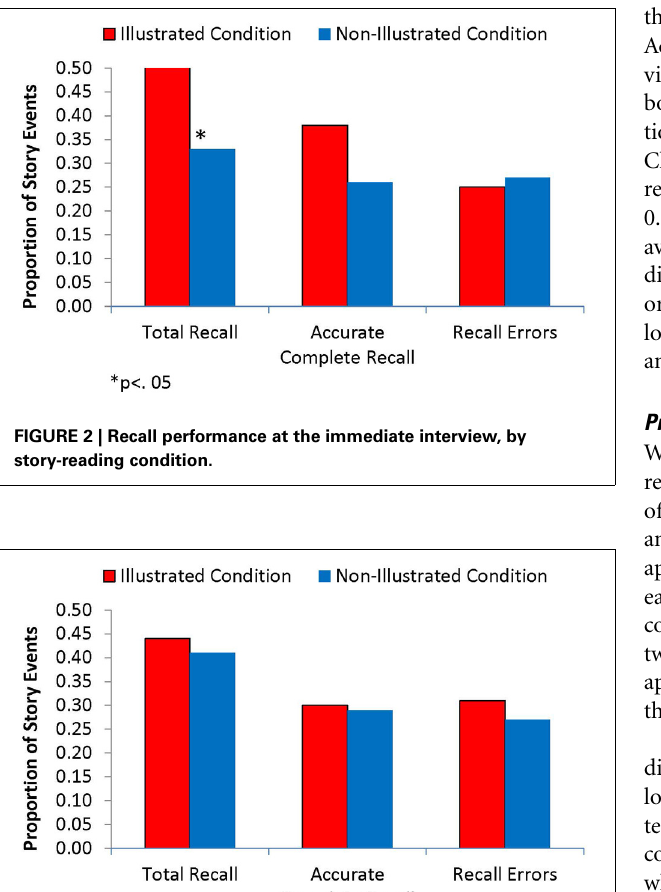
increased children’s abilities to remember the story narrative, particularly in the short